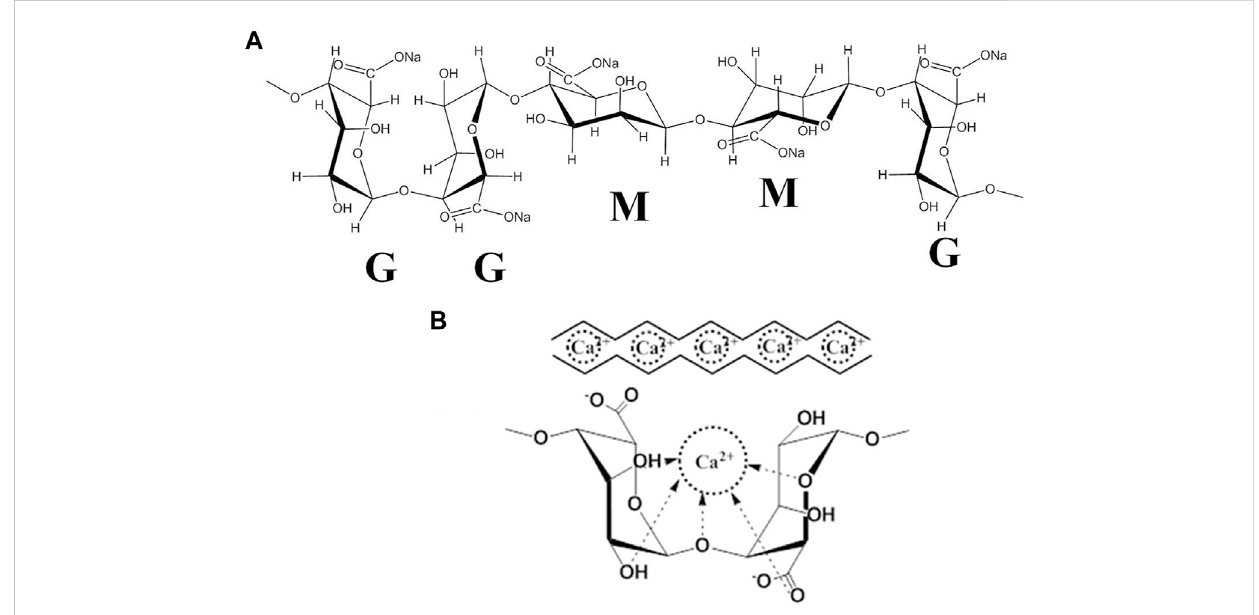
FIGURE 1 (A) The structure and block distribution of sodium alginate. (B) The “ egg-box ” model is formed by the cross-linking of the G-unit of alginate with Ca 2+